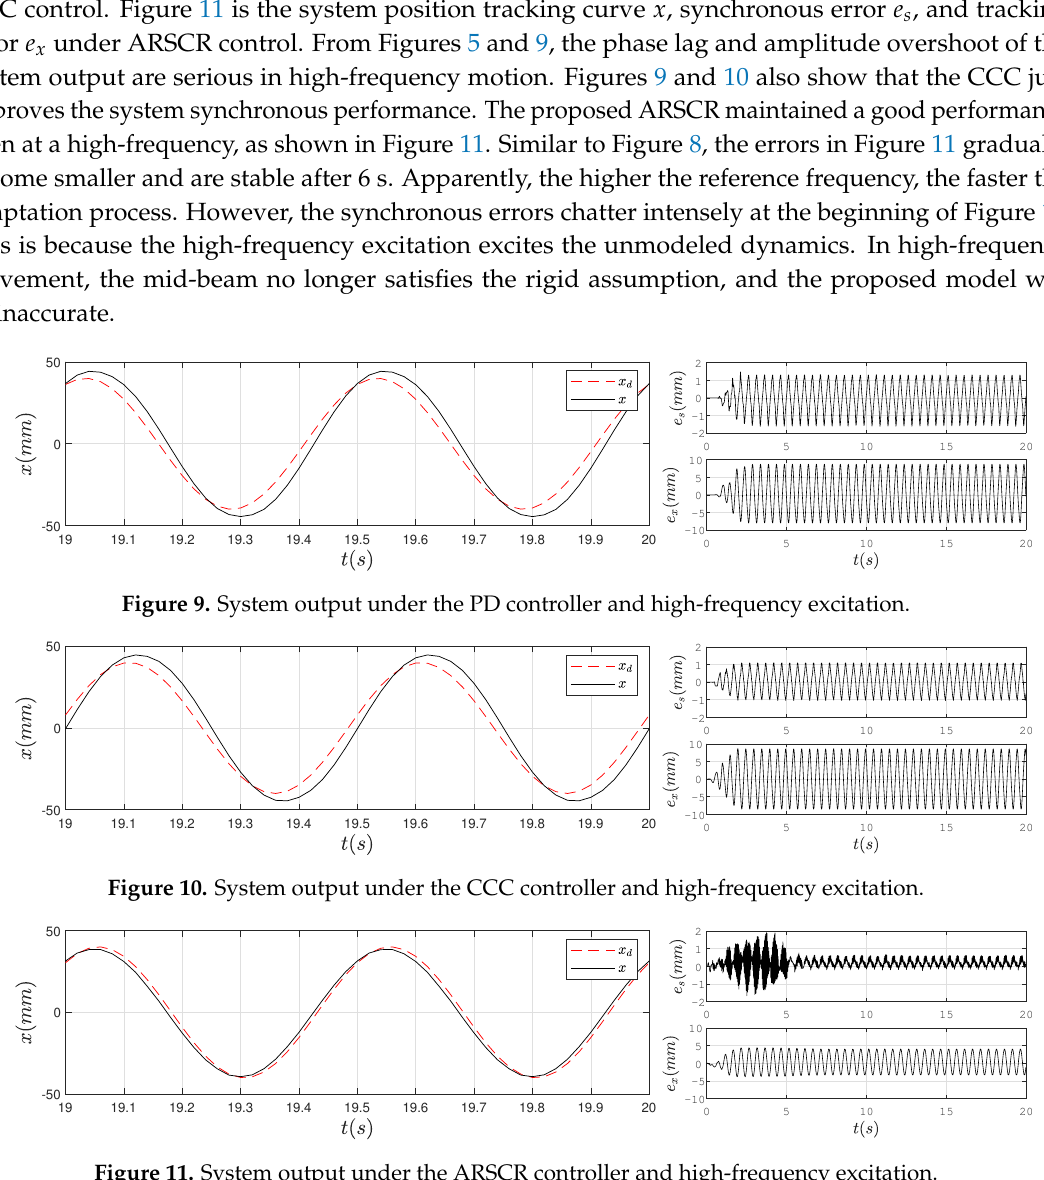
Figure 11. System output under the ARSCR controller and high-frequency